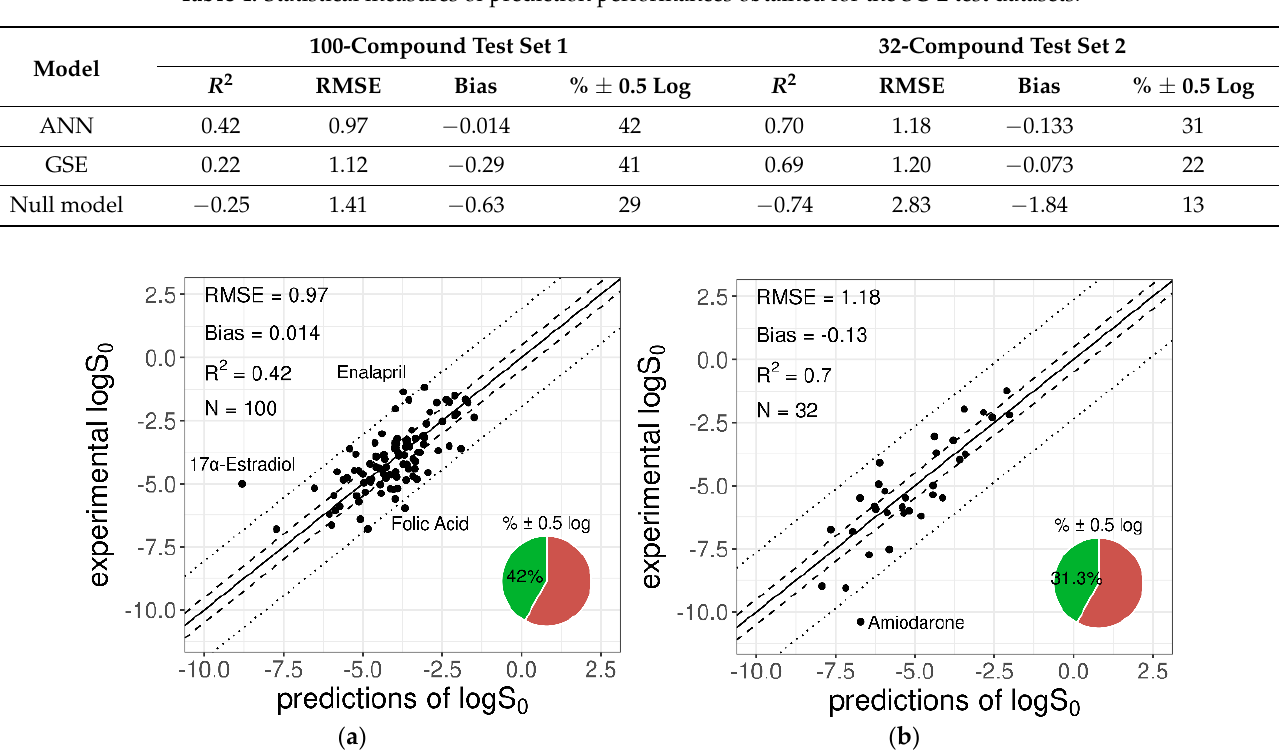
Figure 3. Plots of the experimental versus predicted logS 0 for the 100-compound low-variance tight set ( a ) and the 32- compound high-variance loose set ( b ) provided by the SC-2. The solid diagonal line represents the identity line; dashed and dotted lines represent the displacement from the identity line by ±0.5 log and ±2×RMSE log, respectively. The pie chart refers to the percentage of “correct” predictions (within % ± 0.5 log). Names of outlier compounds are displayed.